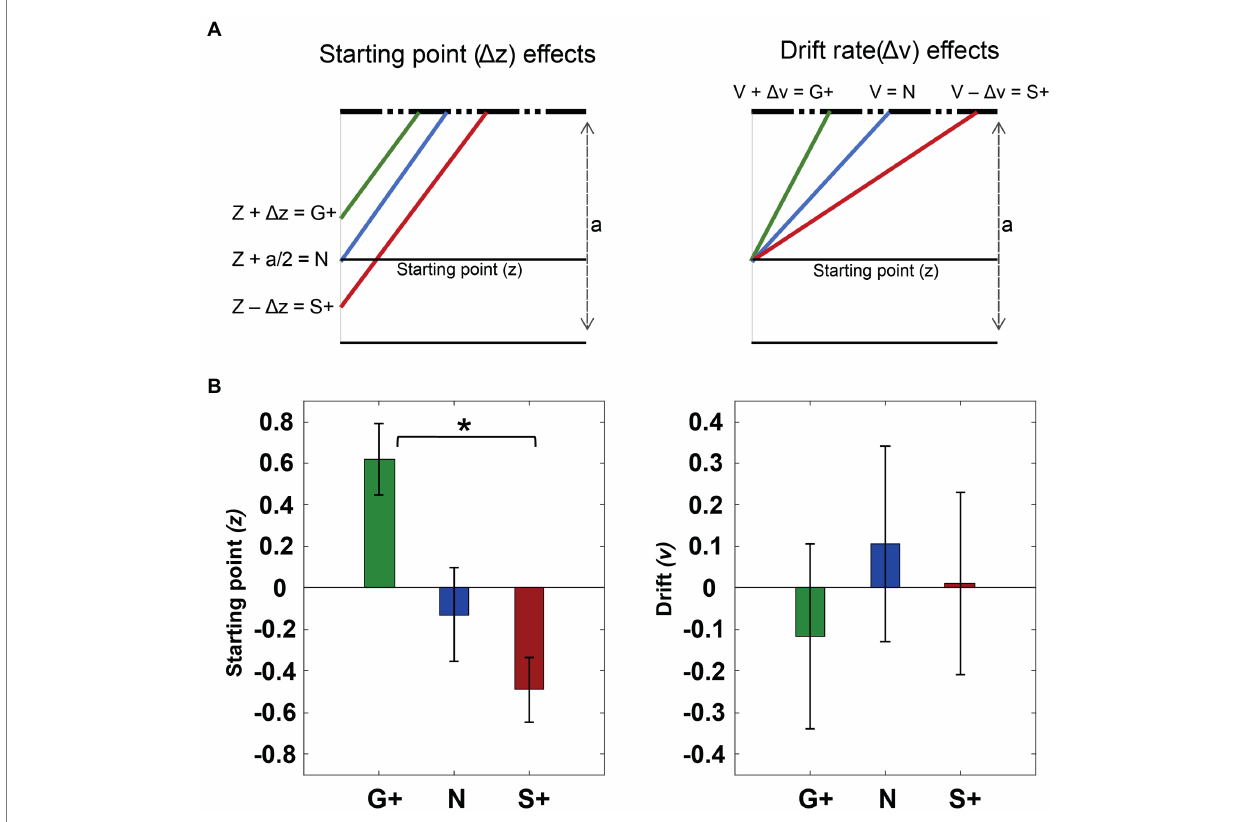
FIGURE 8 Fit data to drift diffusion model (DDM). (A) Fit data to drift diffusion model (DDM). (A) Effects explained with DDM. the effect at the starting point z, we assume that it is close to the boundary in the Go+ condition, in the middle of the threshold (a) in the neutral condition, and finally moving away from the correct boundary in the Stop+ condition. Similarly in the drift model (v), we assume that it increases for the Go+ condition and decreases in the Neutral and Stop+ conditions. (B) The zscore average of the effect of the starting point parameter (z) and the zscore average of the parameters of the drift rate(v) (right panel). Error bars represent 1 SE from the